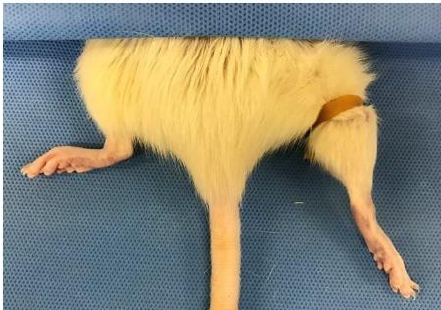
Figure 3. Non-invasive ischemic preconditioning (IPC) in rats. Hind limb blood flow was occluded using a tourniquet at the inguinal level.